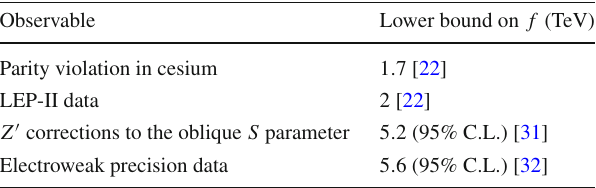
Table 1 Bound on the symmetry breaking scale f of the SLHM obtained from several observables Observable Lower bound on f (TeV) Parity violation in cesium 1 . 7 [22] LEP-II